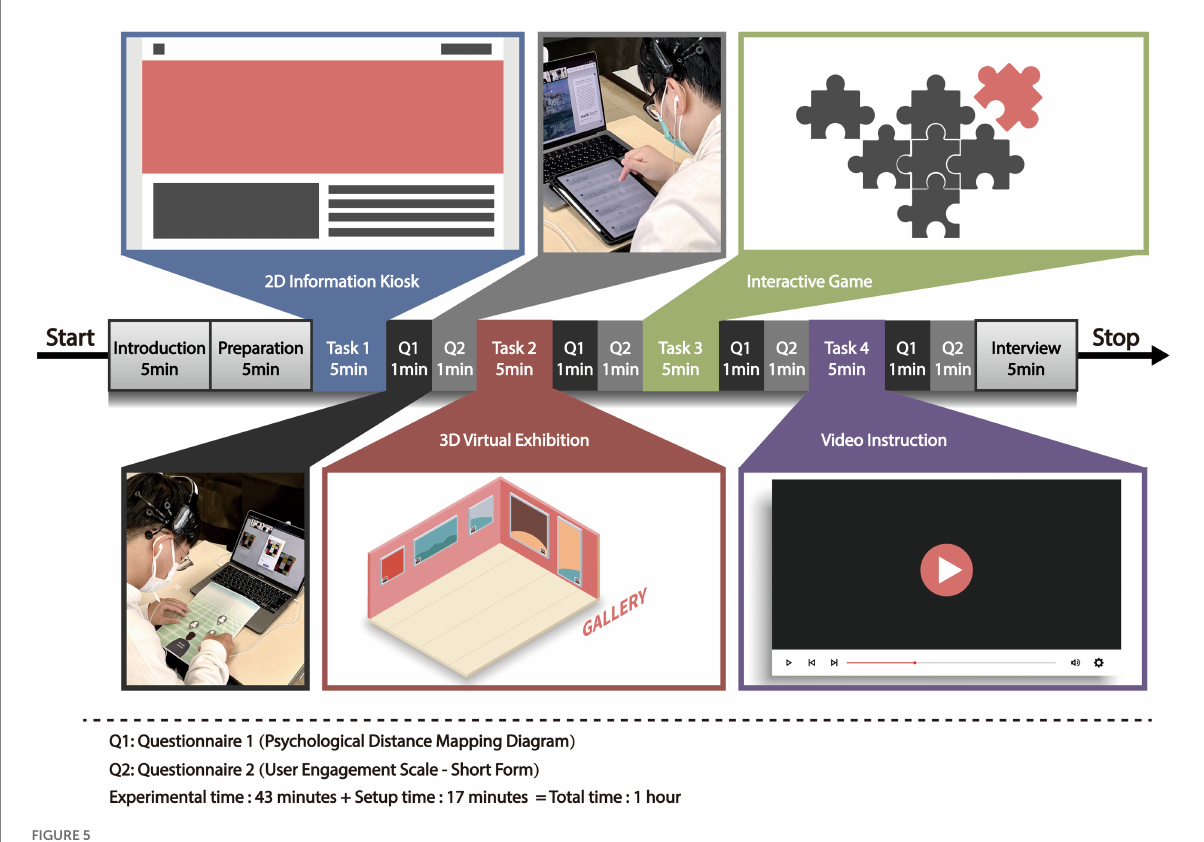
FIGURE 5 Flow diagram of the experimental procedures.